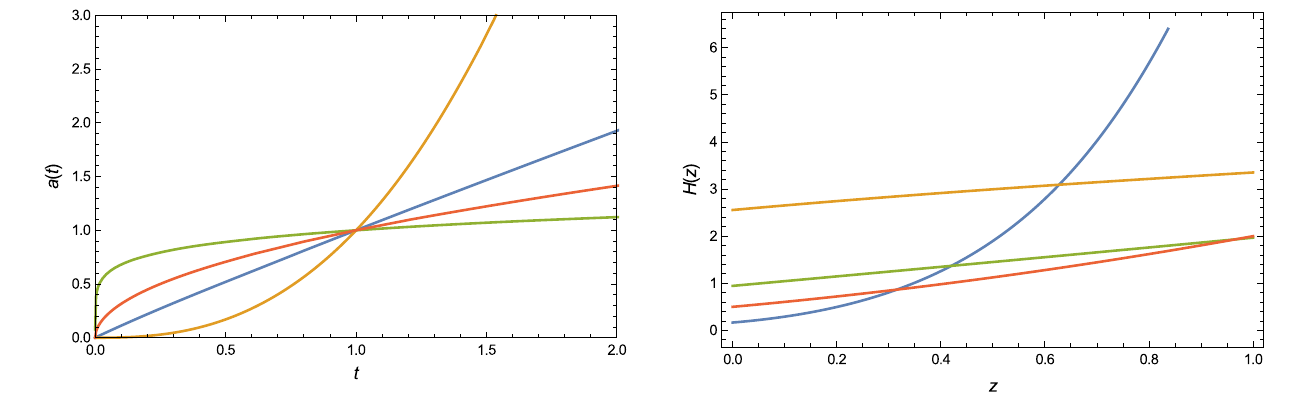
Fig. 1 Evolution of the scale factor with cosmic time for power-law potential. The various colors take on the following values of the index n . Red: n = 3, blue: n = 0 . 09, yellow: n = − 0 . 7, and green: n = − 5